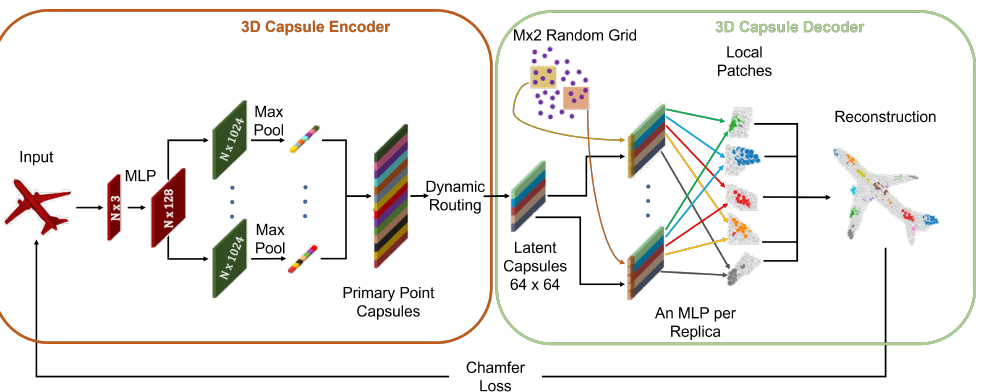
Figure 22. 3D Point Capsule Network [130]